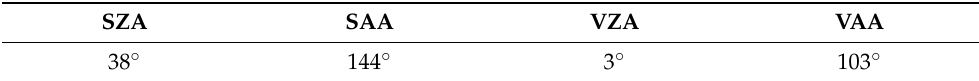
Table 3. Reference angles for